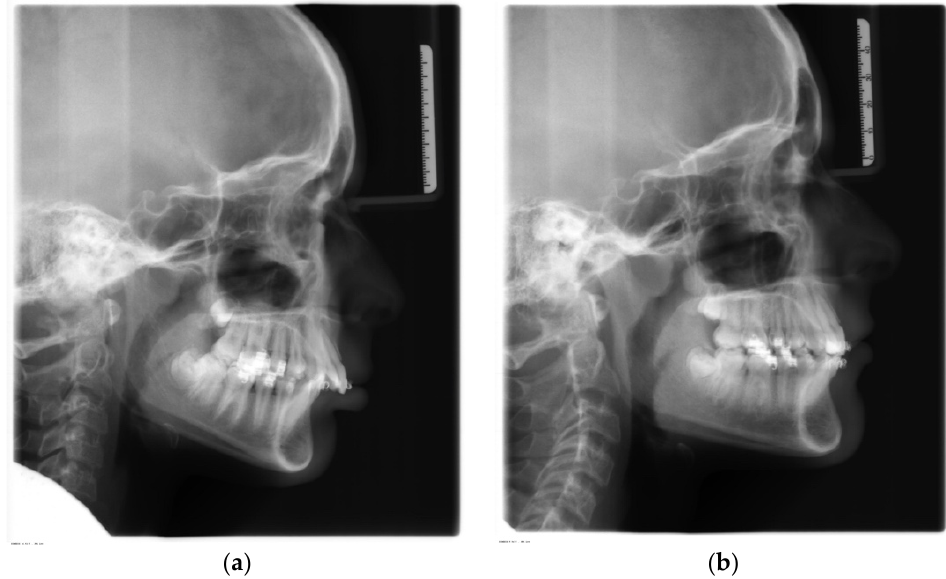
Figure 4. ( a ) Before treatment with MARA device. ( b ) After treatment with MARA appliance.